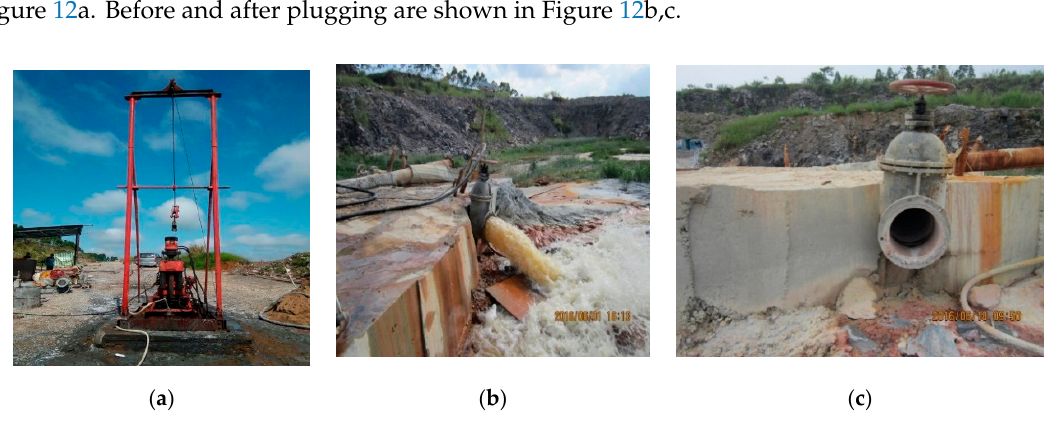
Table 3. A table of grouting control.